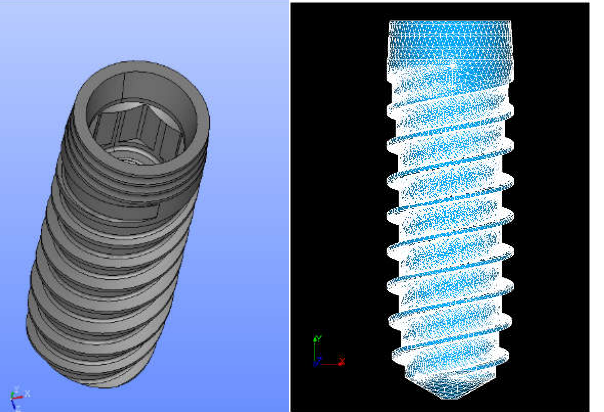
Figure 1. ( Left ) implant model. ( Right ) finite element mesh with 479.132 elements and 106.370 nodes.